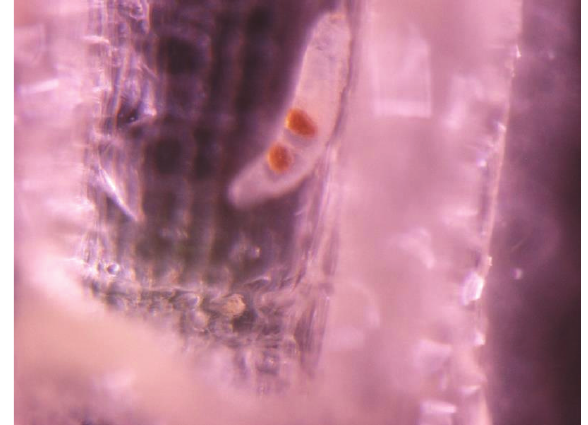
Figure 5: A recently hatched first instar. The orange spots are vacuoles of yolk carried over from the